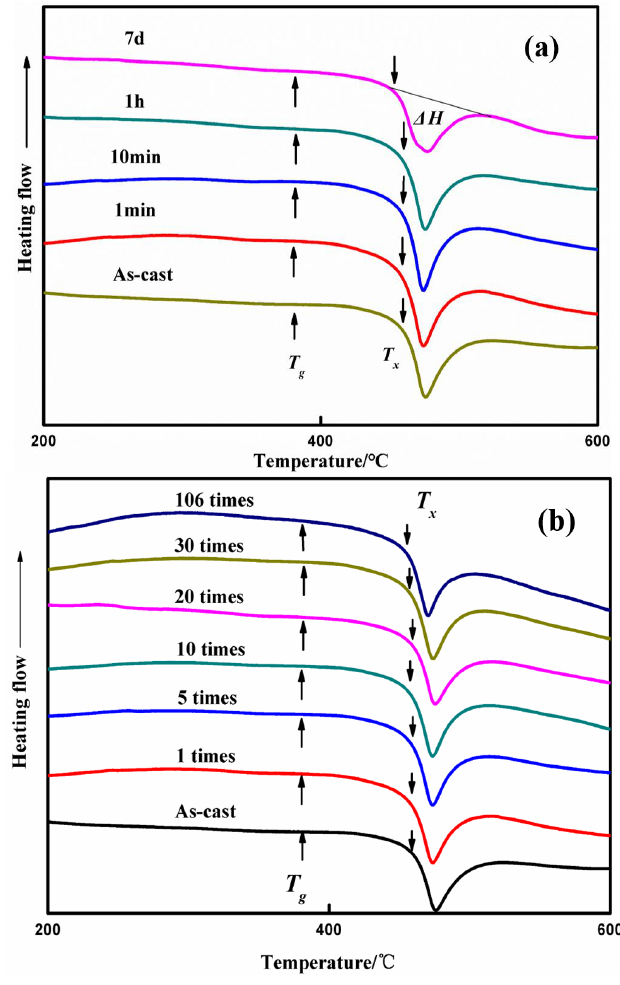
Figure 4. DSC traces after different experimental treatments: ( a ) single cycle and different annealing time in CT; ( b ) 1 min and different thermal cycles.